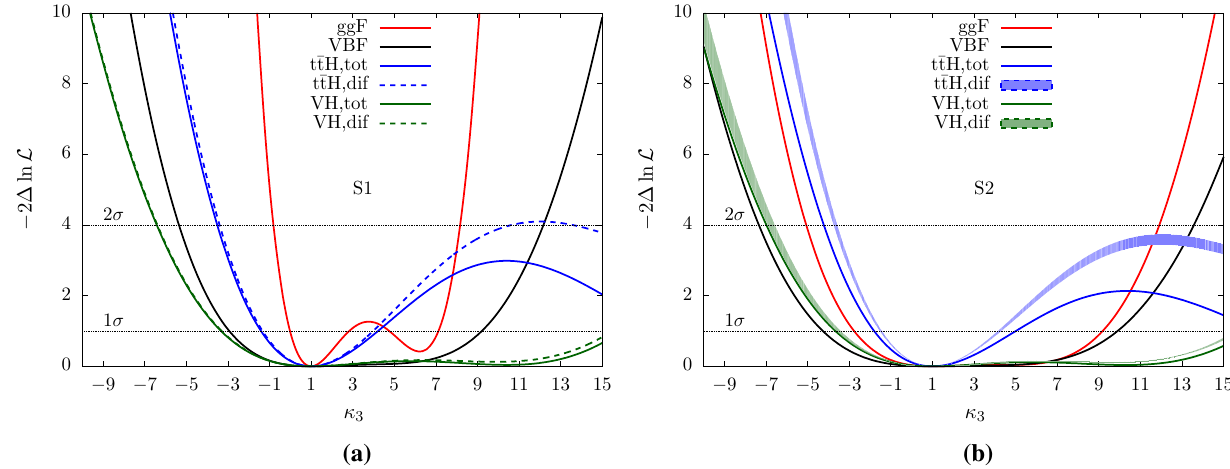
Fig. 12 1 σ and 2 σ bounds on κ 3 from single production processes, based on future projections for ATLAS-HL at 14 TeV. Left: only statistical uncertainty (S1). Right: experimental systematic uncertainty and theoretical uncertainty included